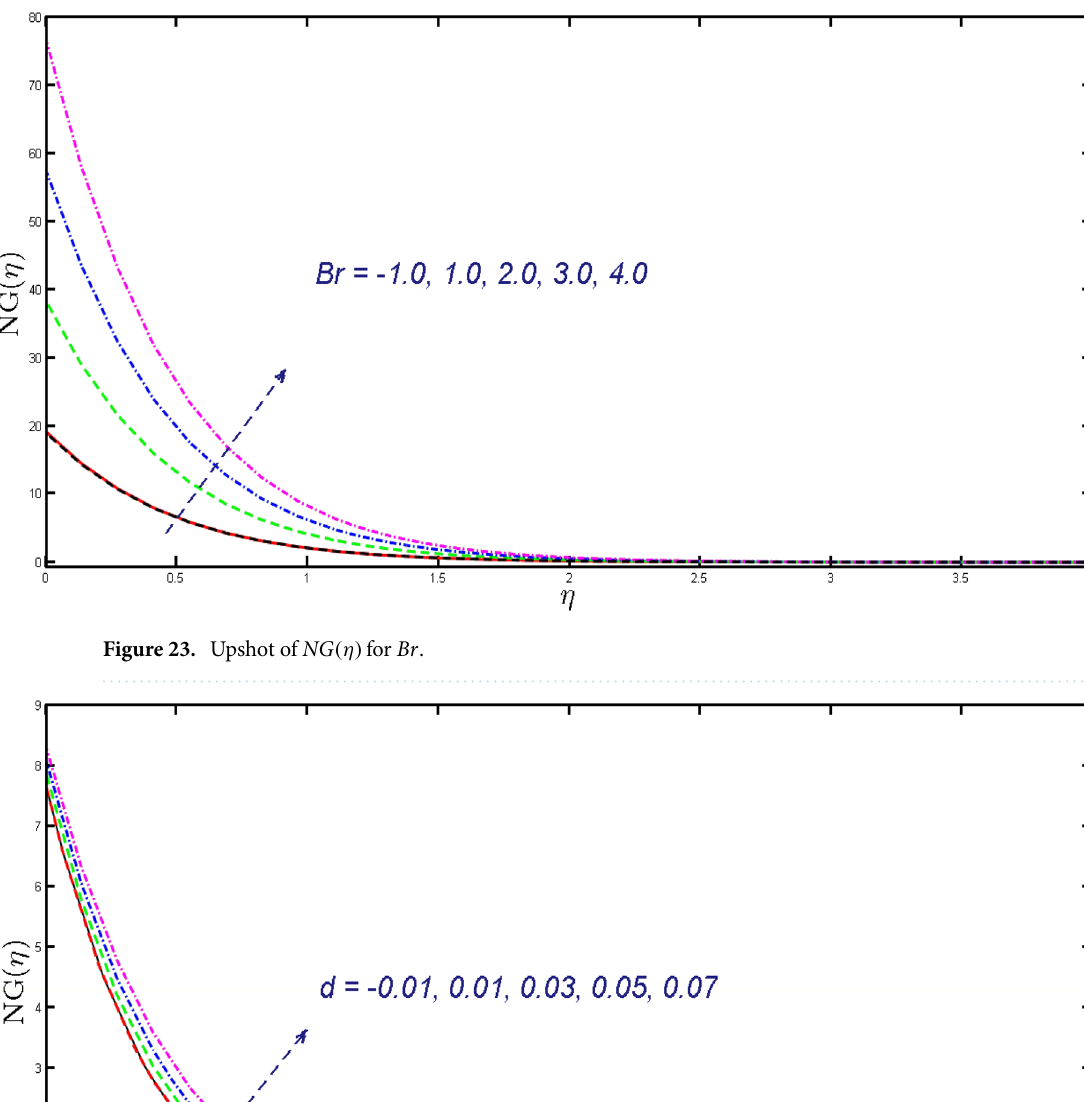
Figure 24. Deviation of NG (η) for d